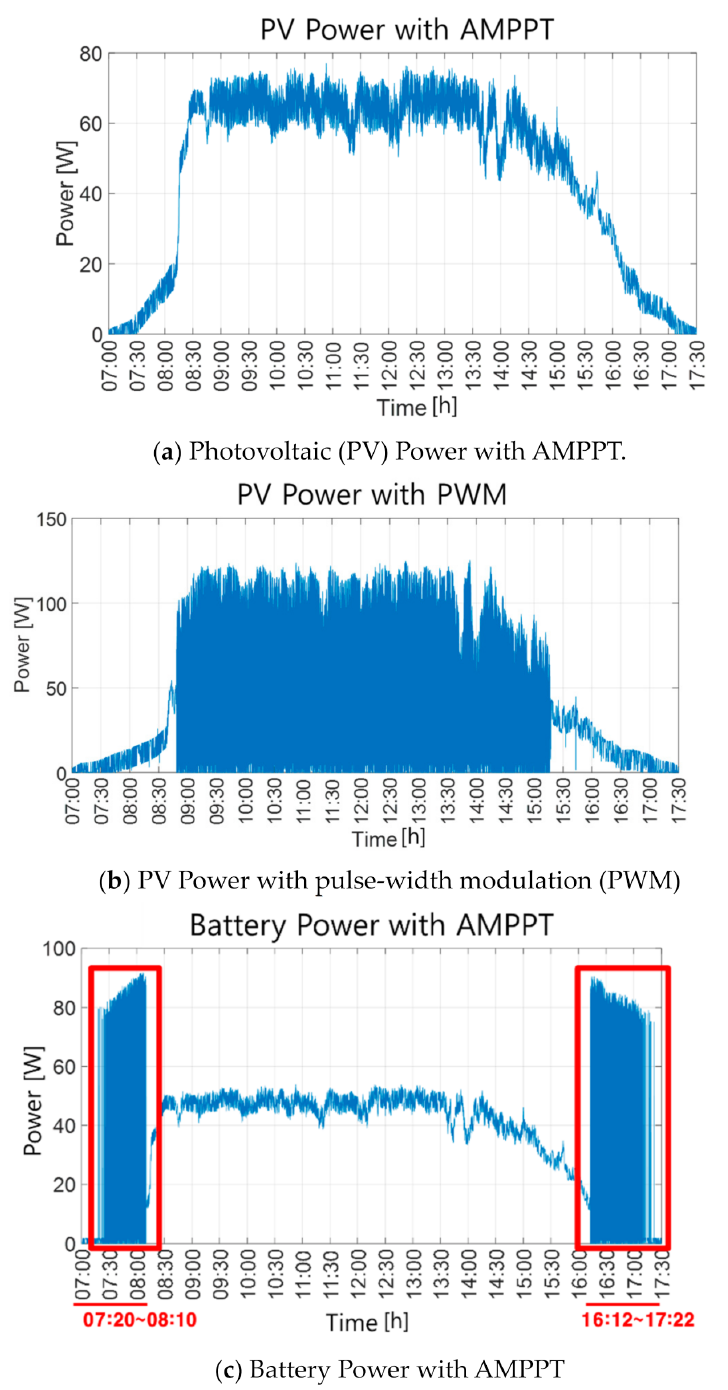
Figure 10. Graph of the power generation for one day produced by Solar1 and Solar2. ( a ) is PV Power iith AMPPT. ( b ) is PV power with PWM controller. ( c ) is Battery Power with